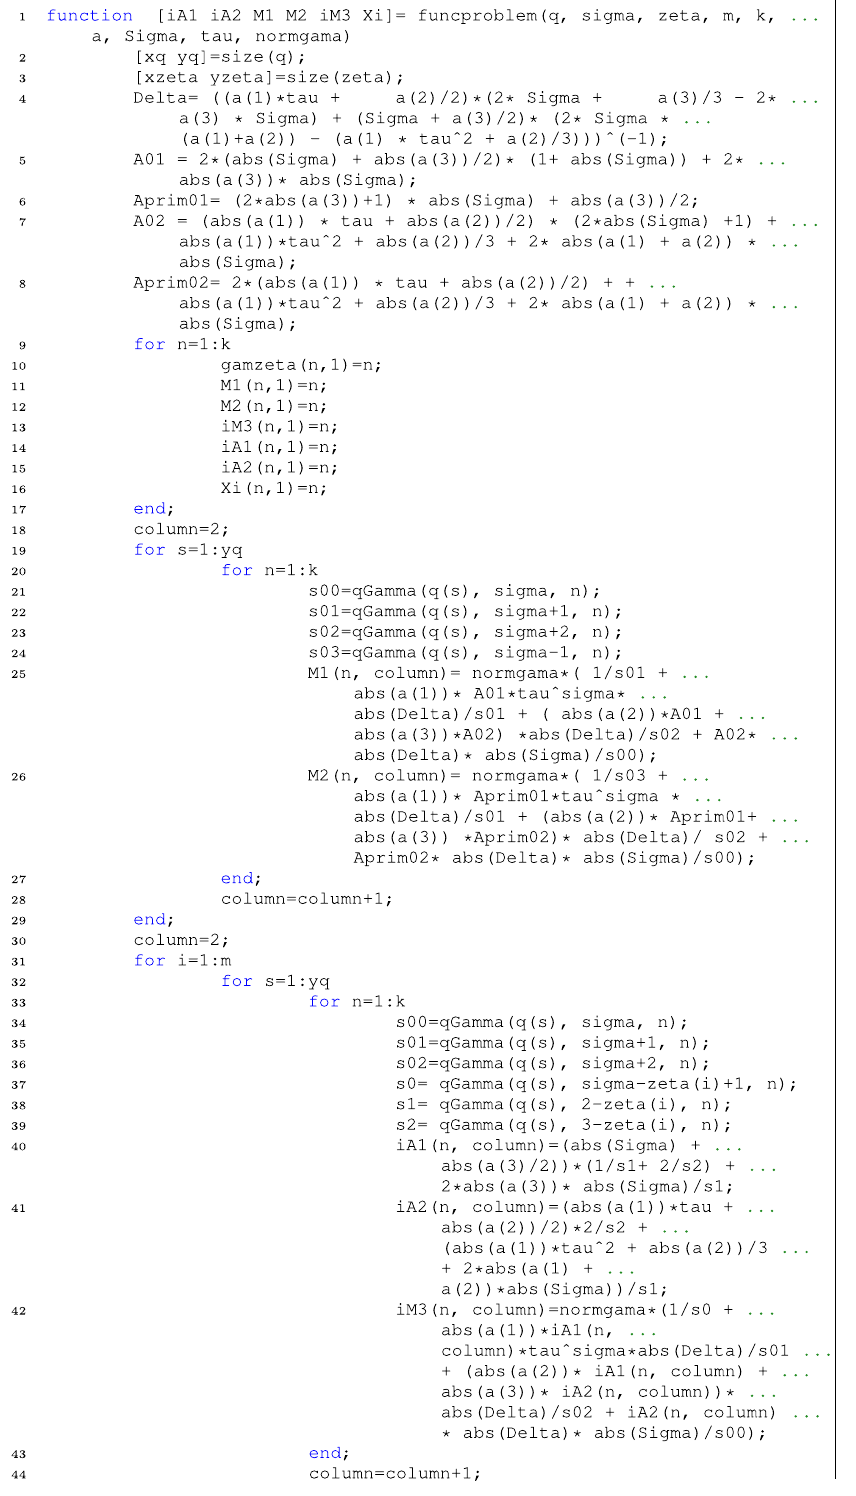
Algorithm 6 The proposed method for calculating the problem